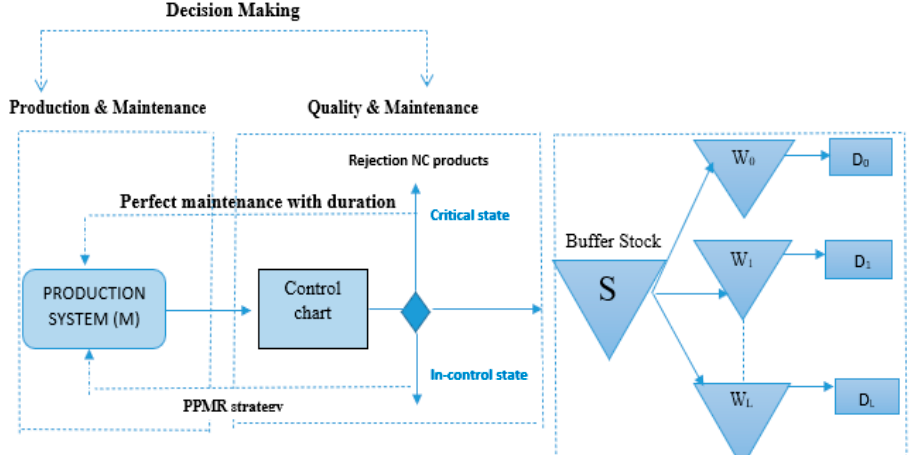
Figure 1. Supply chain management.